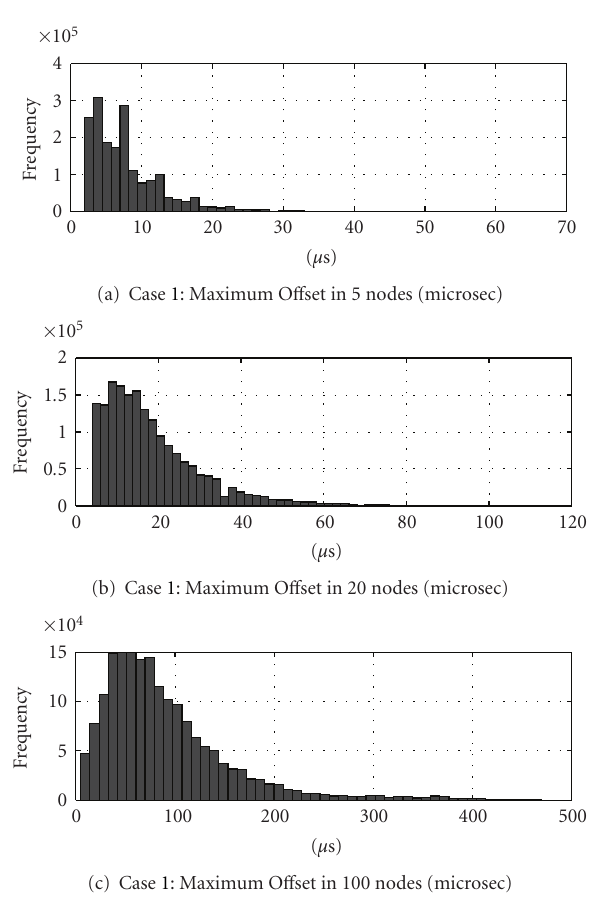
Figure 6: Histogram of the maximum o ff set value in Case 1. Figure 7: Histogram of the maximum o ff set value in Case